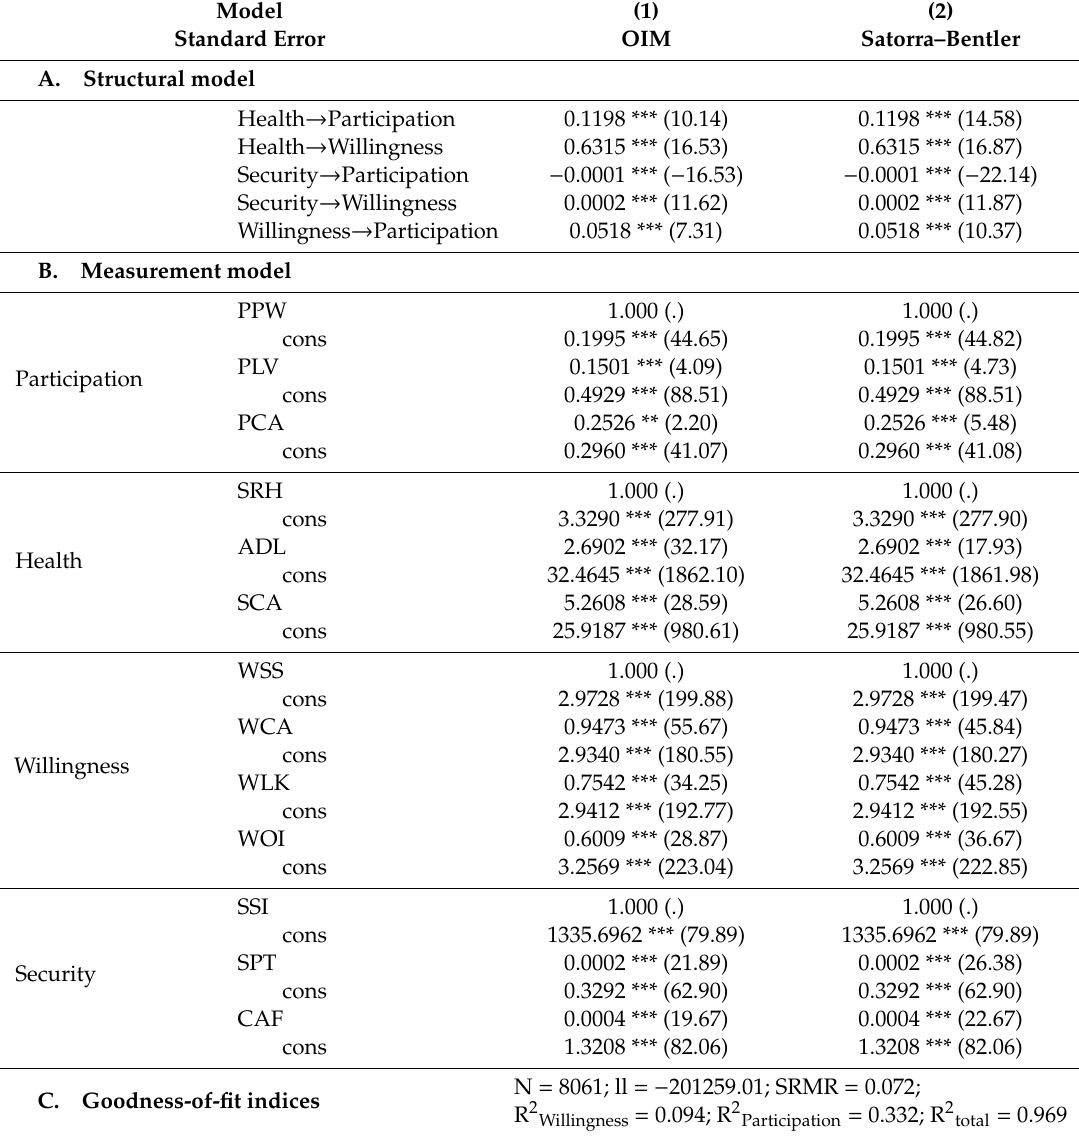
Table 4. Model maximum likelihood estimation